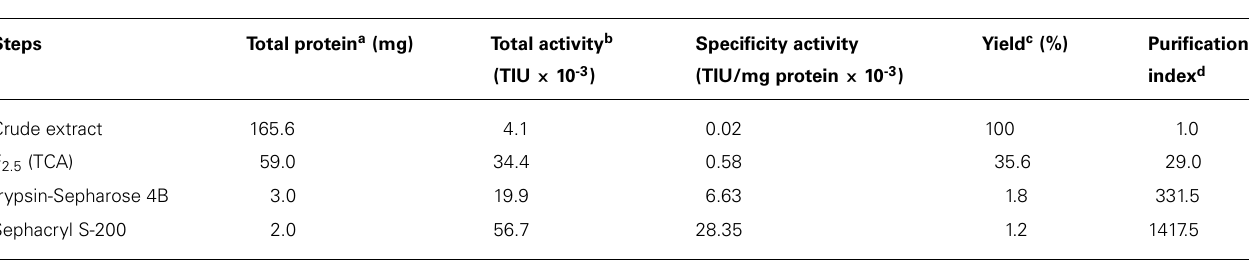
Table 1 | Purification steps of a trypsin inhibitor from J. curcas cake.